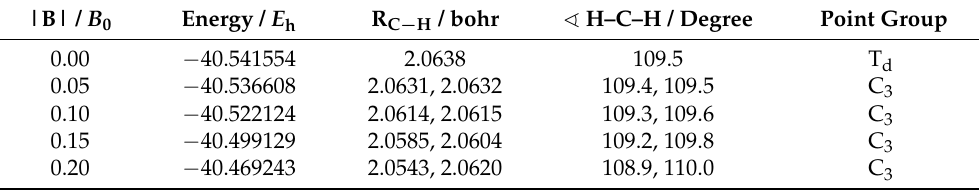
Table 2. Equilibrium geometries of CH 4 at the magnetic field strengths considered in this work, optimized with the cTPSS functional and in the u-aug-cc-pVTZ basis. In all cases, the magnetic field is aligned parallel to one of the C–H